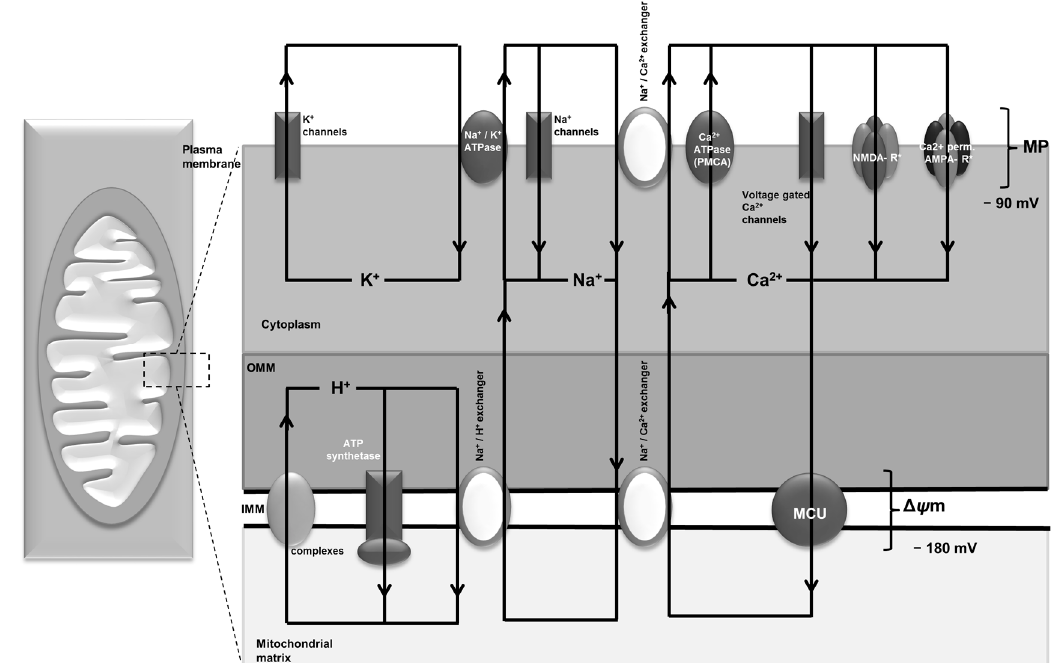
Figure 1. Ion circuits across mitochondrial and plasma membranes of a neuron. The figure shows a schematic drawing of ion circuits across mitochondrial and plasma membranes of a neuron. The respiratory chain is the driving force of these circuits either directly or indirectly by providing adenosine triphosphate (ATP) for all ATP-dependent processes [44]. MCU: mitochondrial Ca 2+ uniporter; ∆ ψ m: mitochondrial membrane potential; MP: membrane potential; NMDA-R: N -methyl- D -aspartate receptor, AMPA-R: α -amino-3-hydroxy-5-methyl-4-isoxazolepropionic acid receptor; OMM: outer mitochondrial membrane; IMM: inner mitochondrial membrane; PMCA: plasma membrane Ca 2+ ATPase.